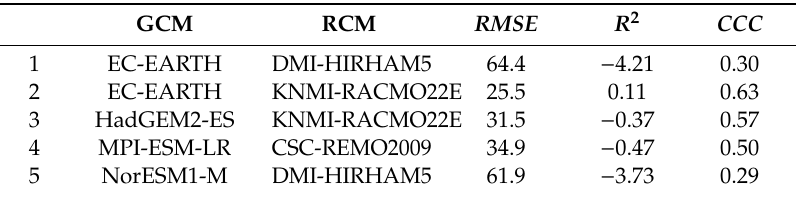
Table 8. Mean monthly precipitation errors of the used GCMs-RCMs. RMSE units are in mm, R 2 and CCC are unitless.